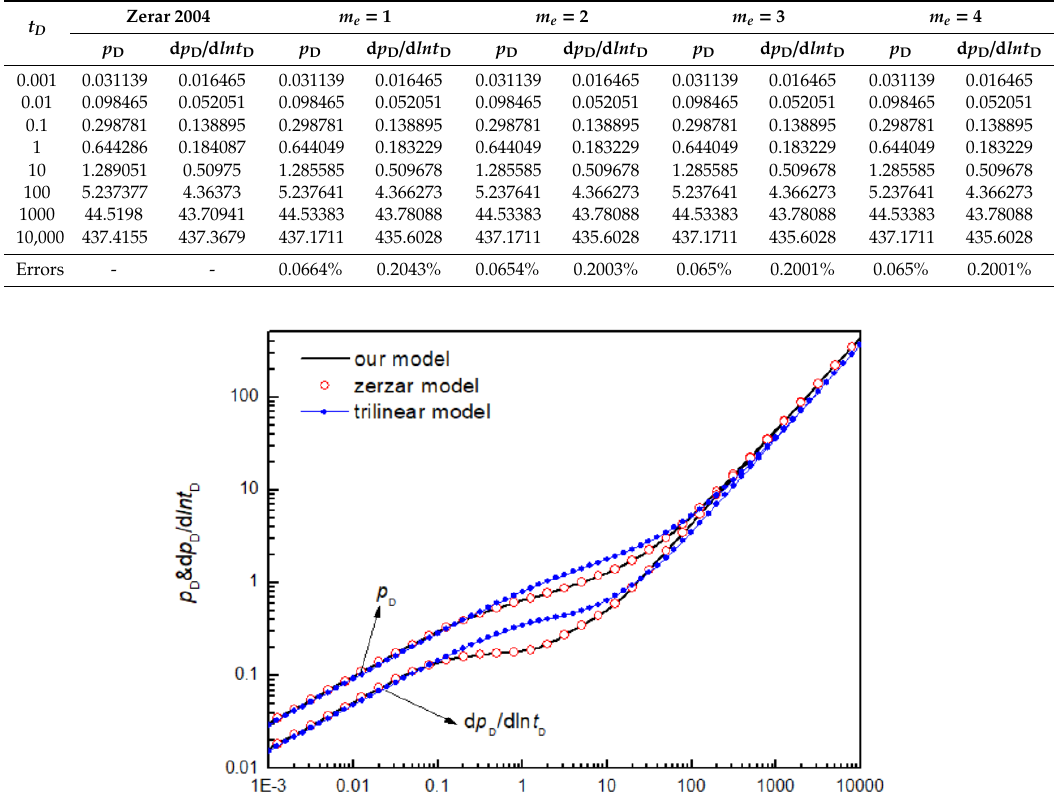
Figure 4. Model verification of Zerzar model and our model ( n f = 3, m e = 1).